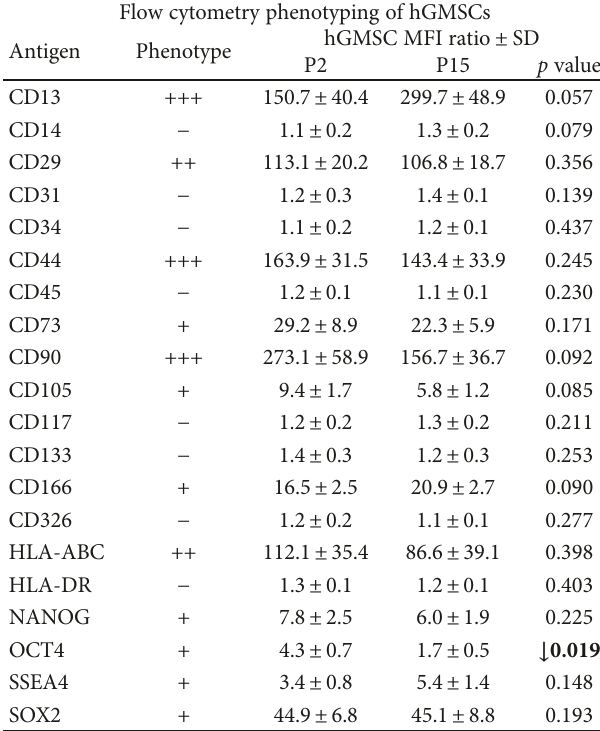
Table 2: Cyto fl uorimetric analysis of hDPSCs. Flow cytometry phenotyping of hDPSCs